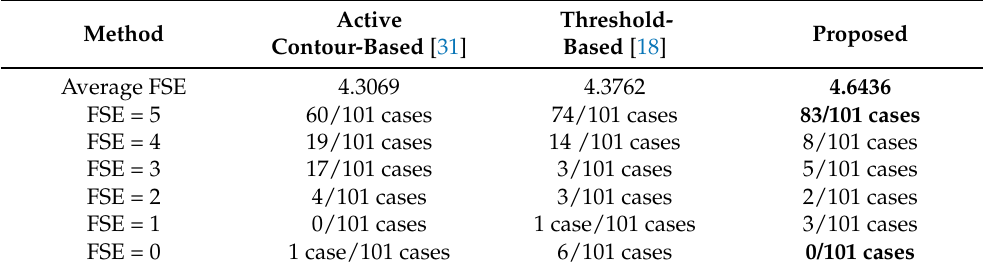
Table 9. Comparison of the results in the DRISHTI-GS dataset with reproduced algorithms with FSE.